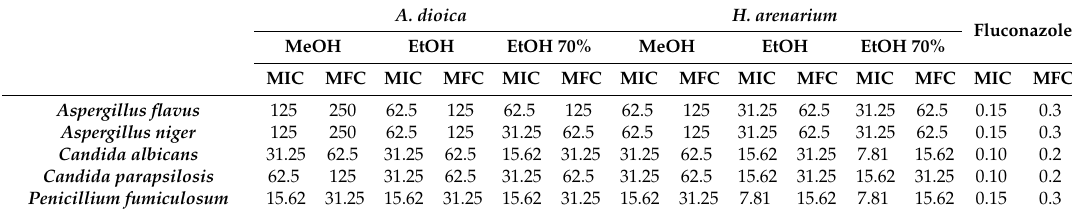
Table 8. Minimum inhibitory concentration MIC (mg/mL) and minimum fungicidal concentration MFC (mg/mL) of H. arenarium and A. dioica extracts and standard antibiotic. A. dioica H.